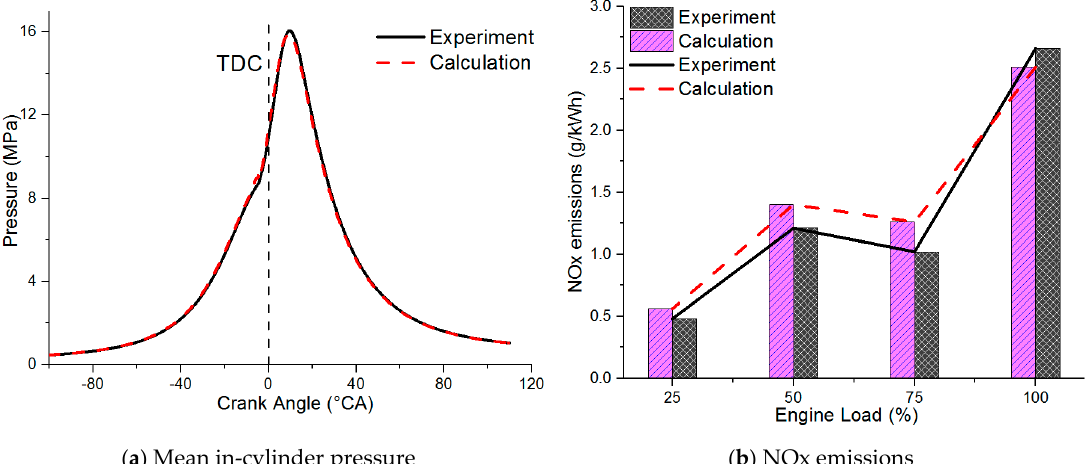
Figure 5. Simulation data (dashed) of mean in-cylinder pressure and NOx emissions against experimental data (solid).